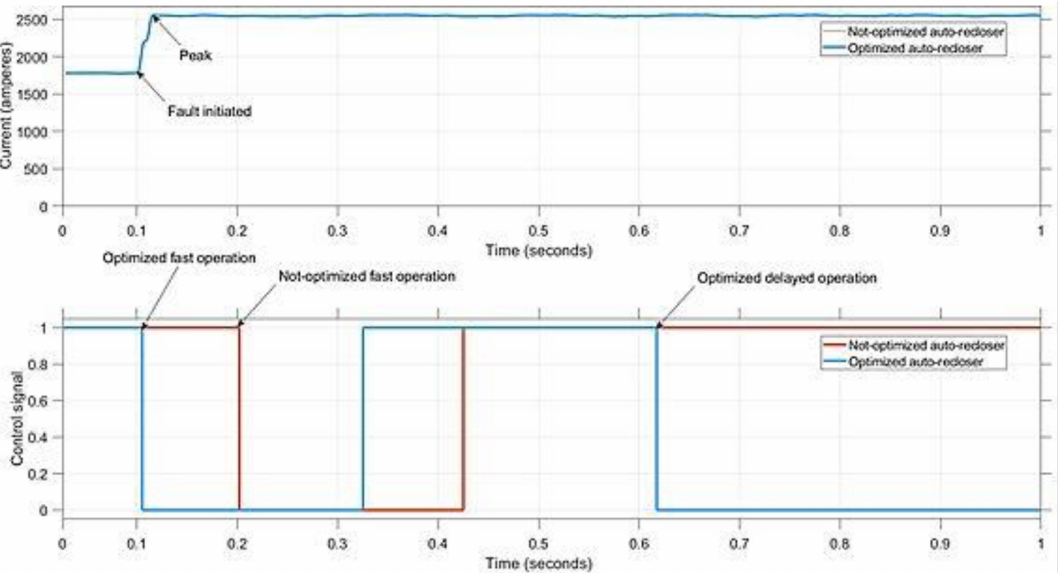
Figure 5. Comparison of the non-optimized and optimized operations for the recloser during a permanent